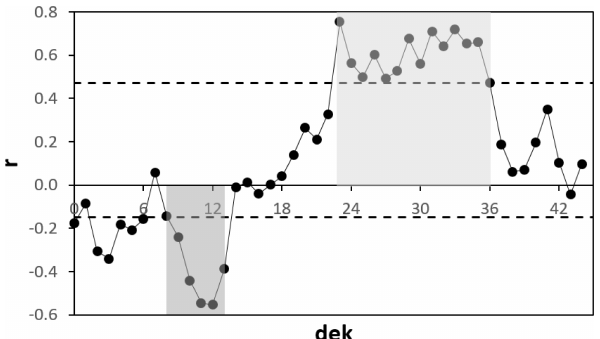
Figure 1. Example of correlogram for one NUTS 2 region in Italy (ITI1, Tuscany). Each value represents the Spearman correlation coefficient between the fAPAR anomaly time series of a specific dekad and the yearly yield anomalies. The two horizontal dashed lines respectively represent the threshold for a positive statistically significant value at p = 0 . 05 and the minimum negative threshold ( r = − 0 . 15, see the main text). Dekads are defined starting from the first one of October of the previous year (e.g. dek = 23 refers to the last dekad of May of the current